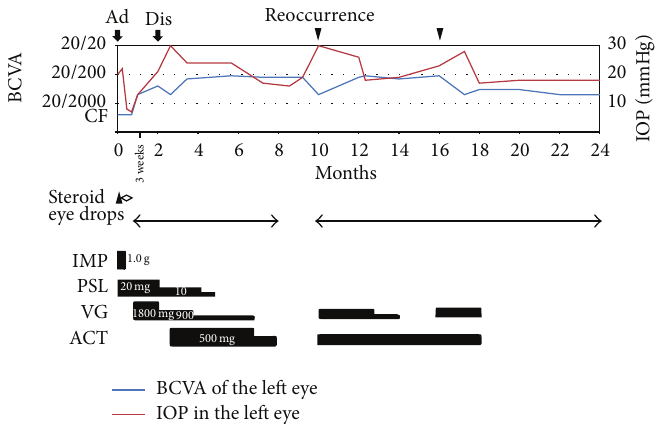
Figure 4: Clinical course of the left eye during two years after the first visit. Ad: admission, dis: discharge, ( 󳶃 ): recurrence of inflammation of theanteriorchamber,( 󳵳 ):injectionofceftazidimeandvancomycin,( ◊ ):eyedropsofceftazidimeandvancomycin,IMP:imipenem/cilastatin, PSL: prednisolone, VG: valganciclovir, and ACT: acetazolamide. (—): best-corrected visual acuity (BCVA), (---): intraocular pressure (IOP), and CF: visual acuity of counting